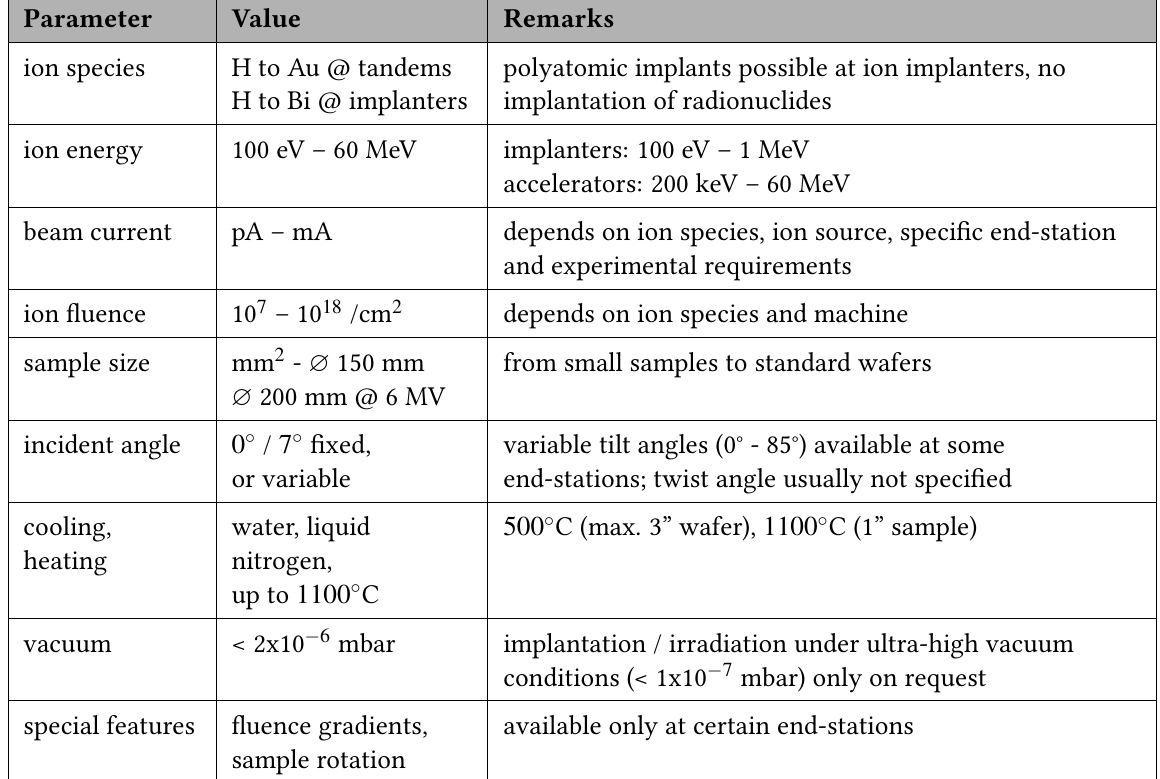
Table 1: Basic parameters of ion implantation / irradiation facilities at